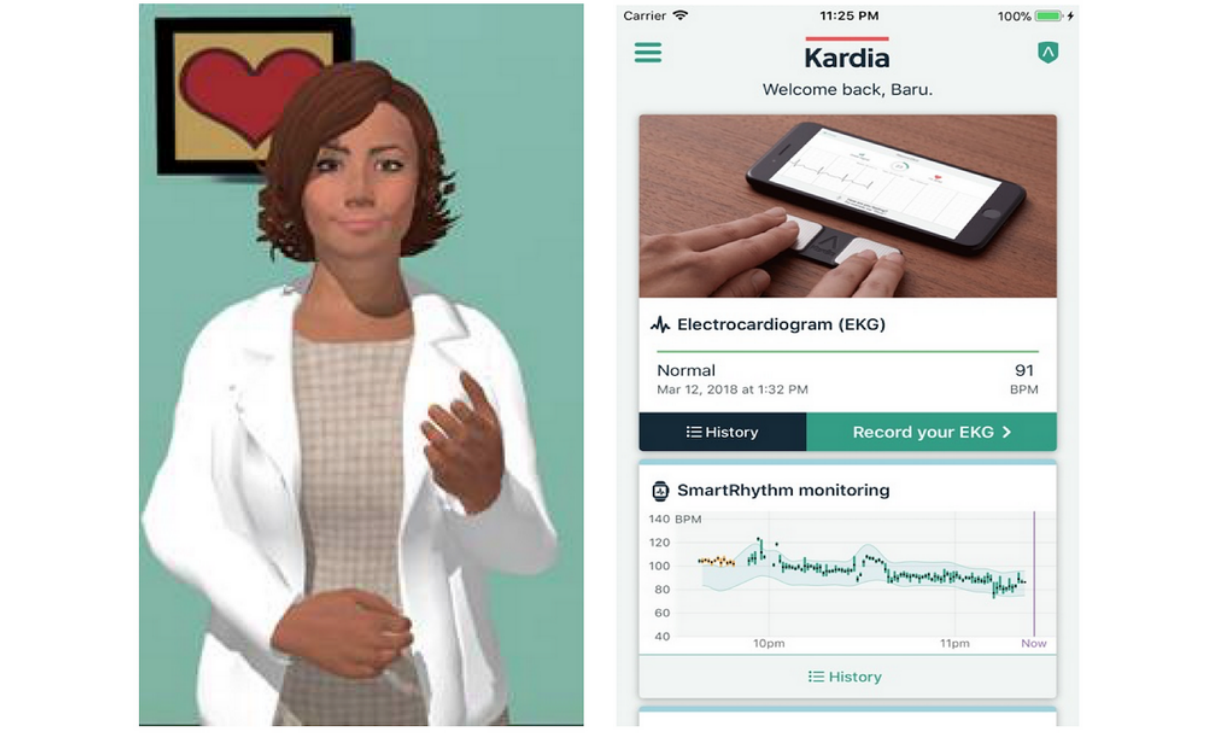
Figure 1. Relational agent as presented by a smartphone to individuals randomized to the intervention (left); Kardia app as presented by a smartphone